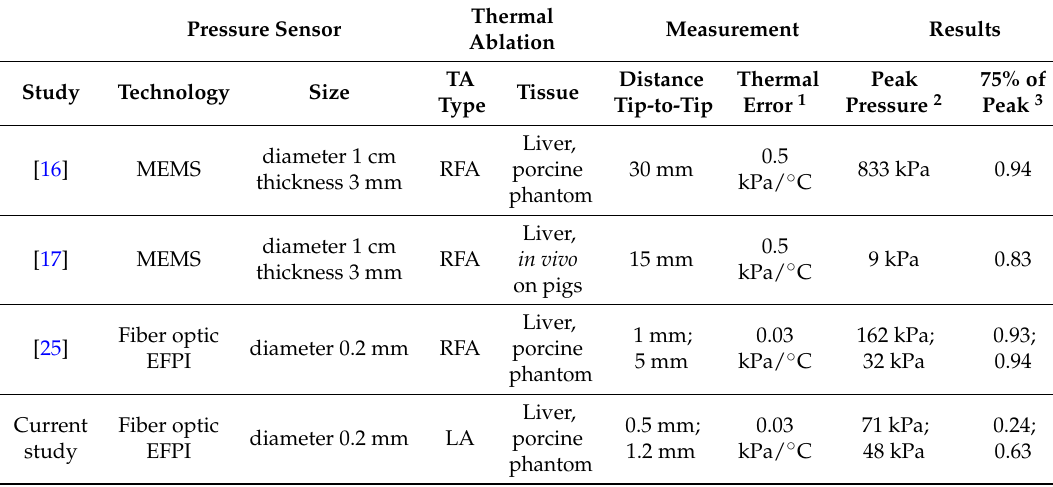
Table 2. Comparison of intra-tissue pressure measurement methodologies and findings in mini-invasive thermal ablation for cancer